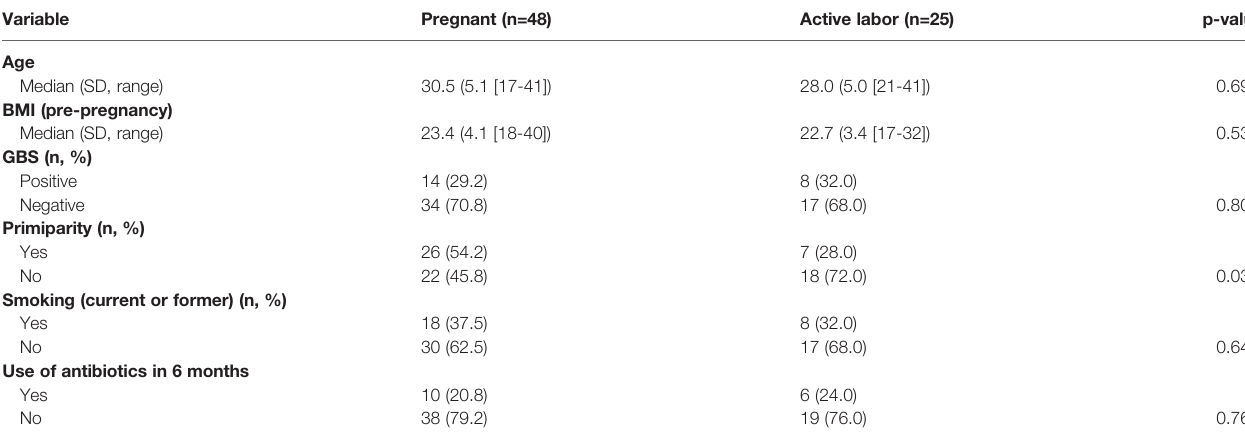
TABLE 1 | Main characteristics of the study